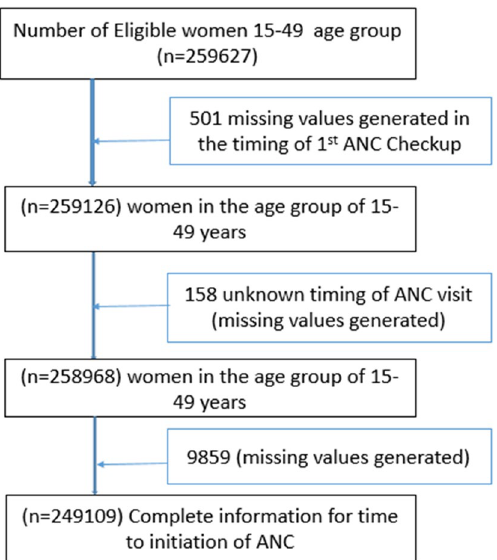
Figure 1. Flow chart showing sample size and sampling procedure to reach the final sample